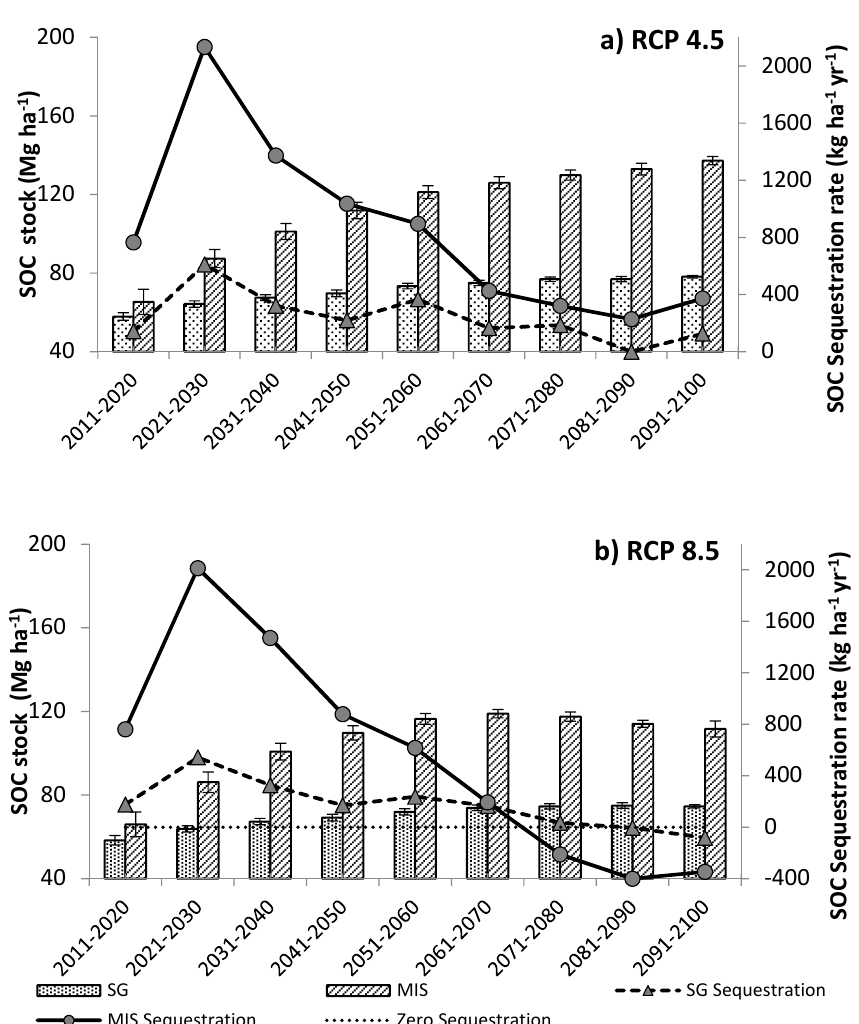
Figure 4. Average decadal SOC stocks and SOC sequestration rates for 20 cm soil layer from DayCent prediction for two representative concentration pathways: ( a ) RCP 4.5 and ( b ) RCP 8.5. MIS = miscanthus; SG = switchgrass; MIS = miscanthus sequestration = SOC sequestration under miscanthus, SG sequestration = SOC sequestration under switchgrass; Zero sequestration = no sequestration over the recent decade; Error bars represent confidence level at p = 0.05 .